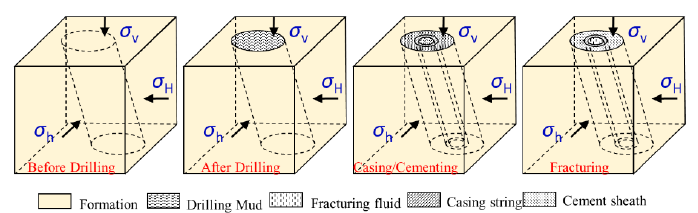
Fig. 4. Stage FEM ( σ V , σ H , σ h are represented the vertical stress, the maximum horizontal stress and the minimum horizontal stress, respectively).